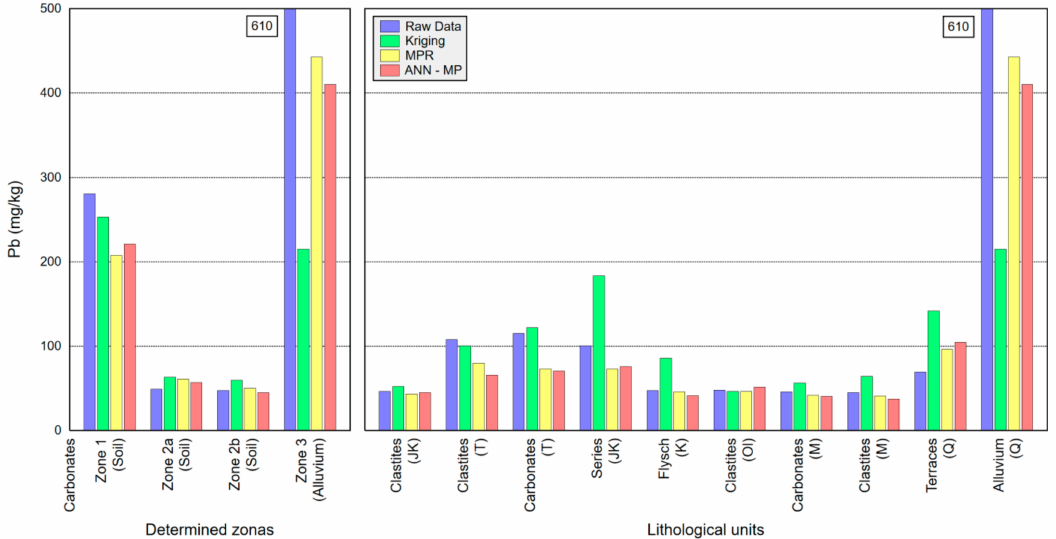
Figure A1. Distribution of predicted values of Lead in isolated lithological units according to the raw data and prediction methods after using the Box-Cox